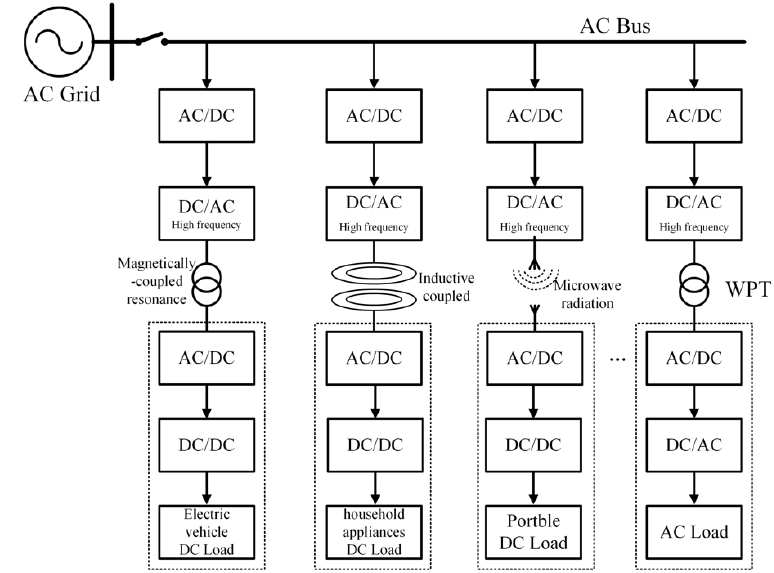
Figure 5. The architecture of WPT in building alternating current (AC) power distribution system.